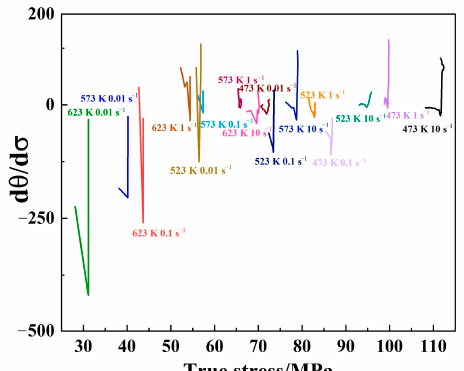
Figure 11. The plots of the derivative of Θ with respect to σ against flow stress ( σ ) for Mg-3Bi alloy.